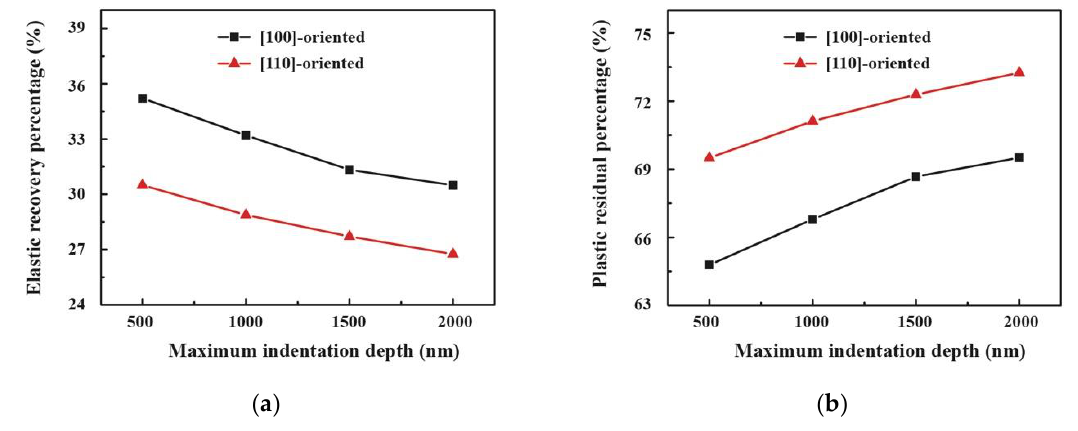
Figure 4. ( a ) Elastic recovery percentage and ( b ) plastic residual percentage versus maximum